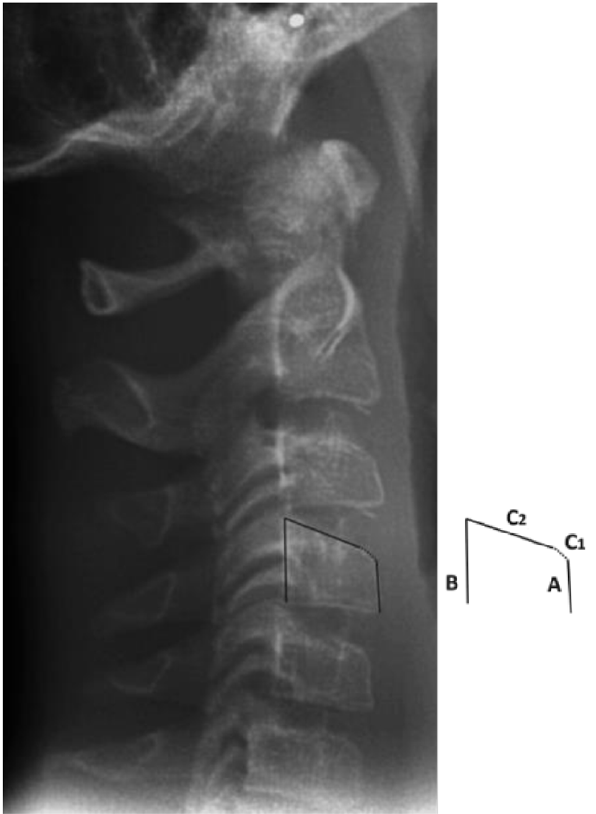
Figure 2. An example of the anterior (A) and the posterior (B) sides of the fourth cervical vertebral body. The anterior side of the body is measured up to the point where the anterior side (A) curves (C1) towards the superior side (C2) of the vertebral